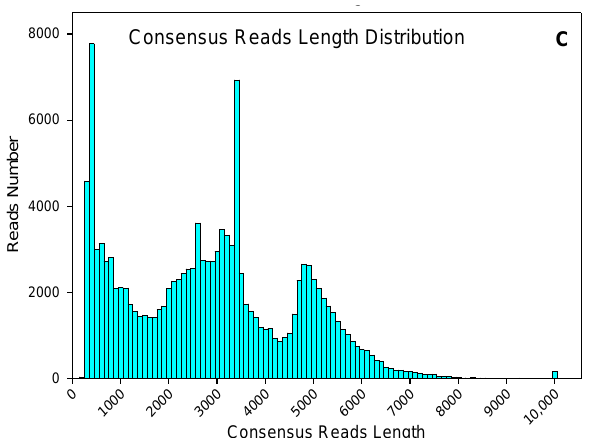
Figure 1. Numbers and length distributions of 9,350,222 subreads ( A ), 254,692 full-length non- chimeric (FLNC) sequences ( B ), and 132,536 consensus reads ( C ) with PacBio single-molecule real- time sequencing method of purslane ( Portulaca oleracea ). The number of genes with no isoform remained 53,977, and 78,559 transcriptions were found between 1 and 10 isoforms (Figure 2). The transcript length extended from 170 bp to 14,287 bp, with an average length of 3061 bp.